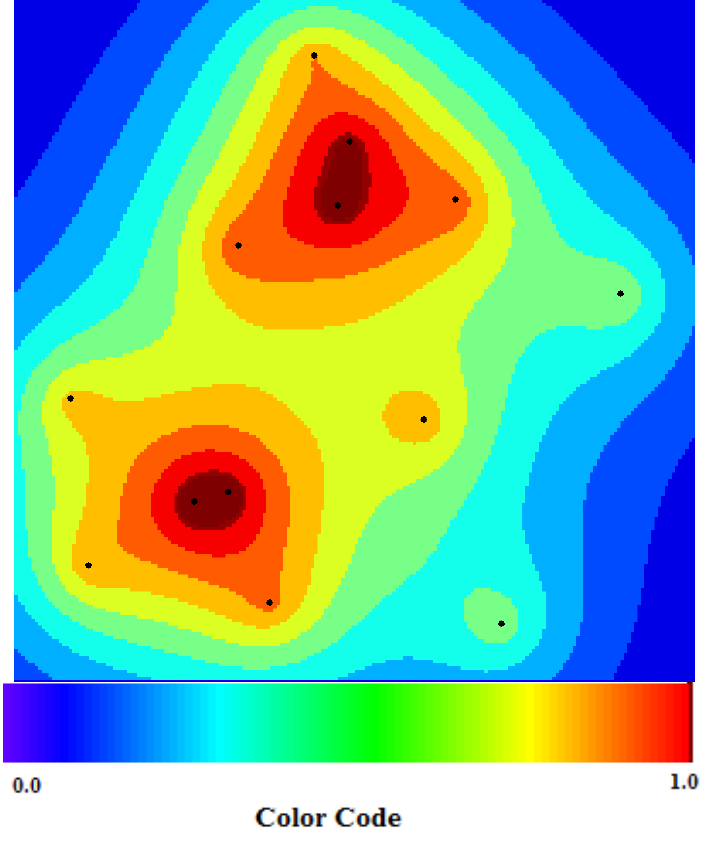
Figure 13. TWC- β scalar field, TWSF ( β * )—the more deep red, the more concentration of epidemics (the deep red zone represents around the 3/1,000 of the whole